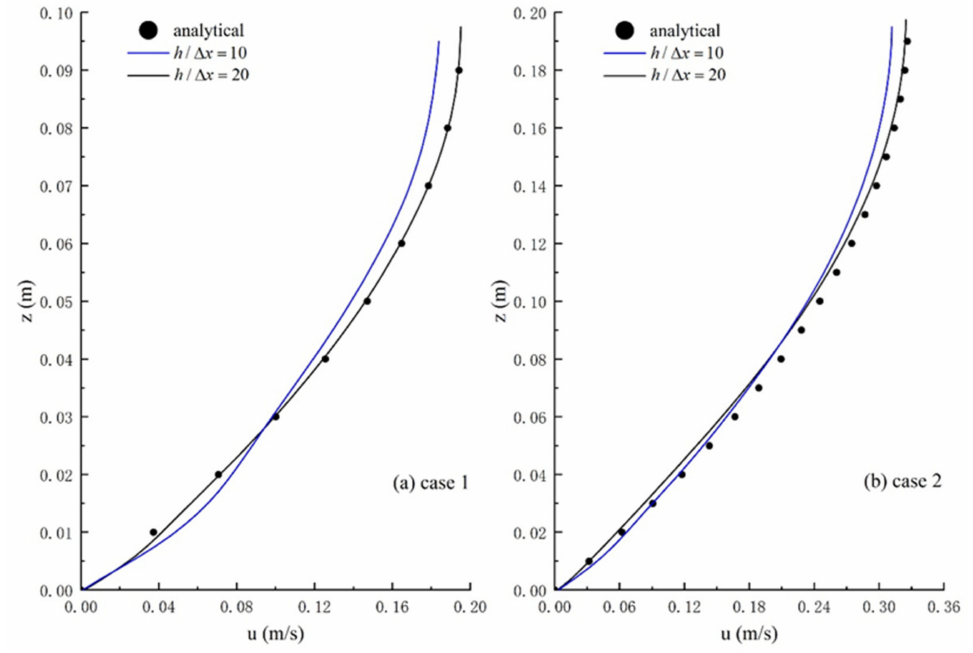
Figure 4. Comparisons of the velocity profiles between numerical results and analytical